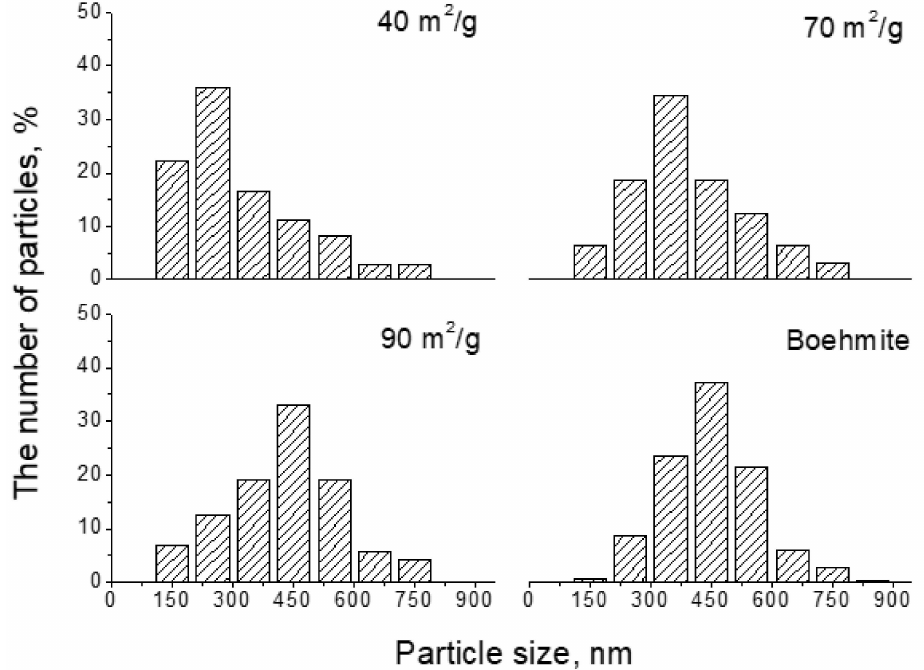
Figure 7. Cross-sectional size distribution of the exfoliated flakes. As the BET value increased, relatively large flakes